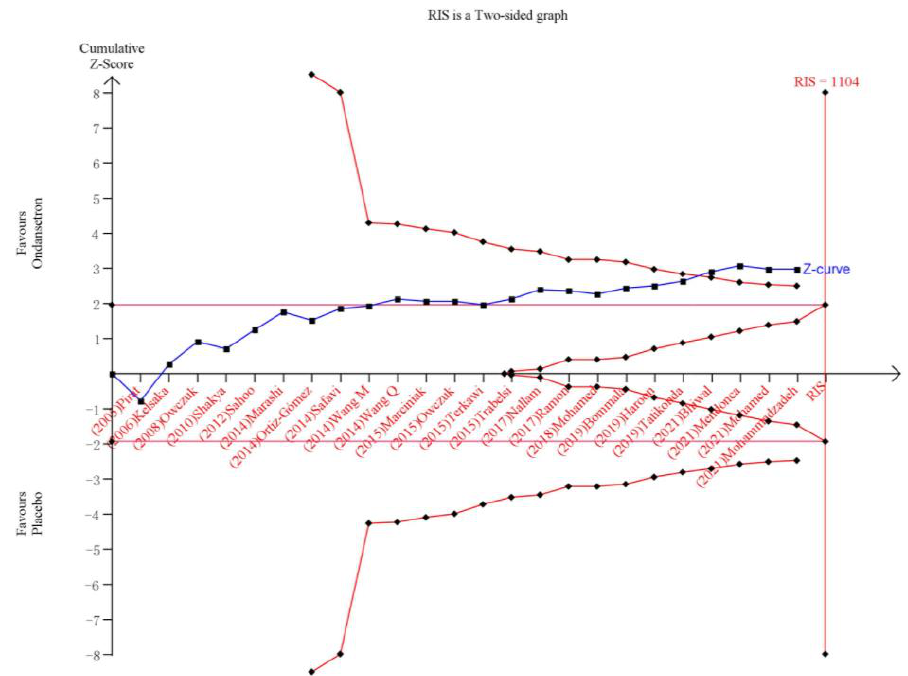
Figure 8. The trial sequential analysis result for the incidence of hypotension.